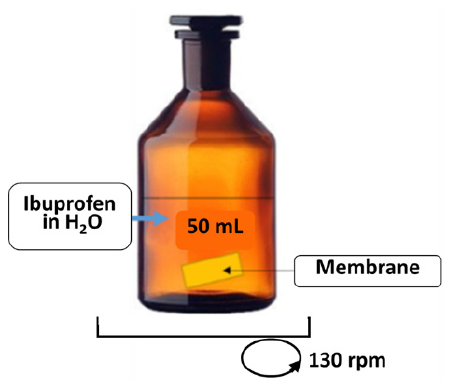
Figure 1. Test of IBU sorption.